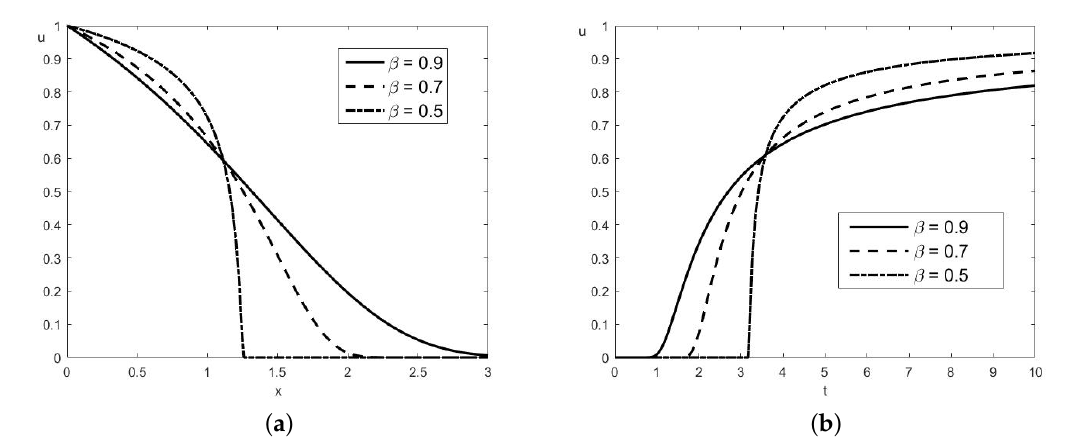
Figure 2. Velocity field u ( x , t ) for α = 0.5 and three different values of β : 0.5,0.7,0.9; a = 10 α , b = 10 β − 1 ; ( a ) u ( x , t ) as a function of x for t = 4; ( b ) u ( x , t ) as a function of t for x =